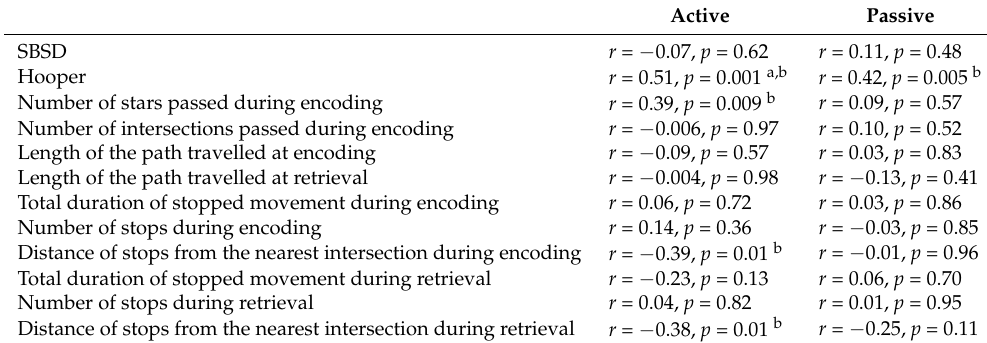
Table 1. Correlations between memory accuracy (percent overlap values) following active and passive encoding, and various neuropsychological factors, as well as task performance